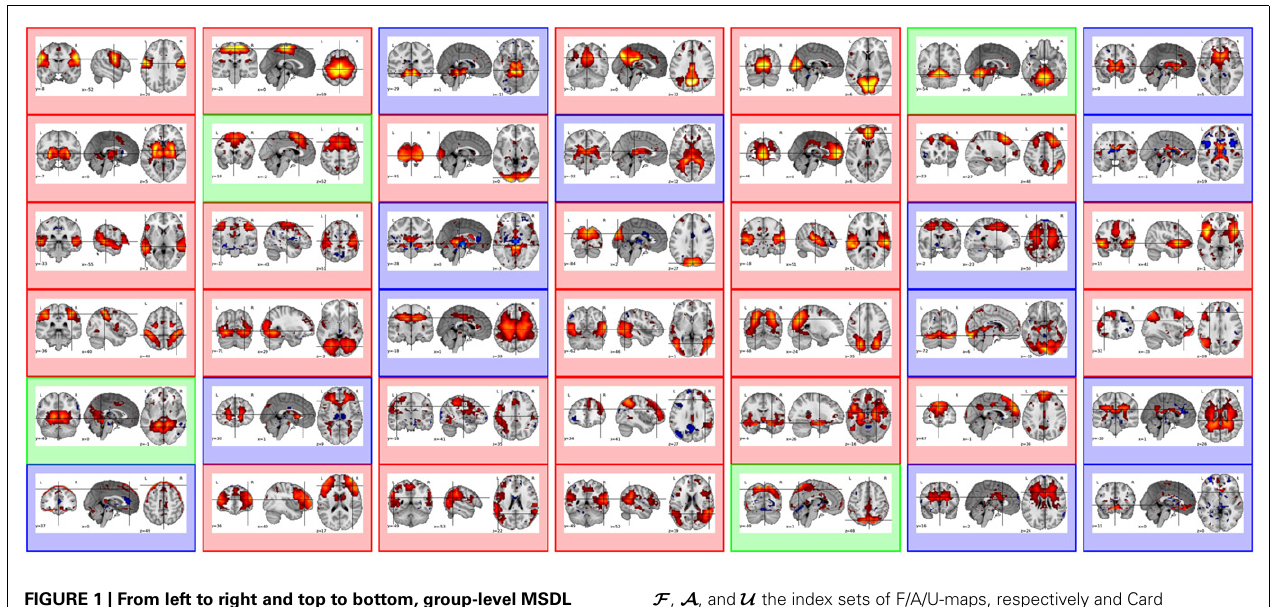
FIGURE 1 | From left to right and top to bottom, group-level MSDL maps V = |v 1 | ... | v 42 | inferred from the multi-subject ( S = 12) resting-state fMRI dataset (Neurological convention: left is left). Functional (F), Artifactual (A), and Undefined (U) maps appear color-coded boxes in red, blue, and green, respectively. Let us denote